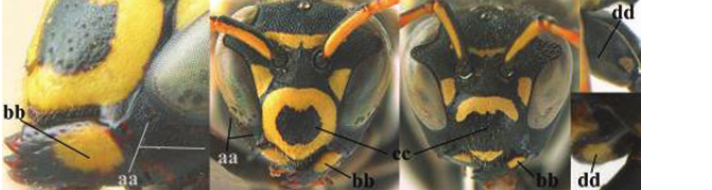
– Malar space black as ventral part of temple (aa); if rarely with small yellow patch then total yellow area of mandible larger than that of yellow patch of malar space and usually not connected to ventral yellow part of temple; mandible with yellow patch (bb); clypeus about as wide as high medially (cc); dorsal colour of hind coxa variable (dd, d); gallicus -group .........................